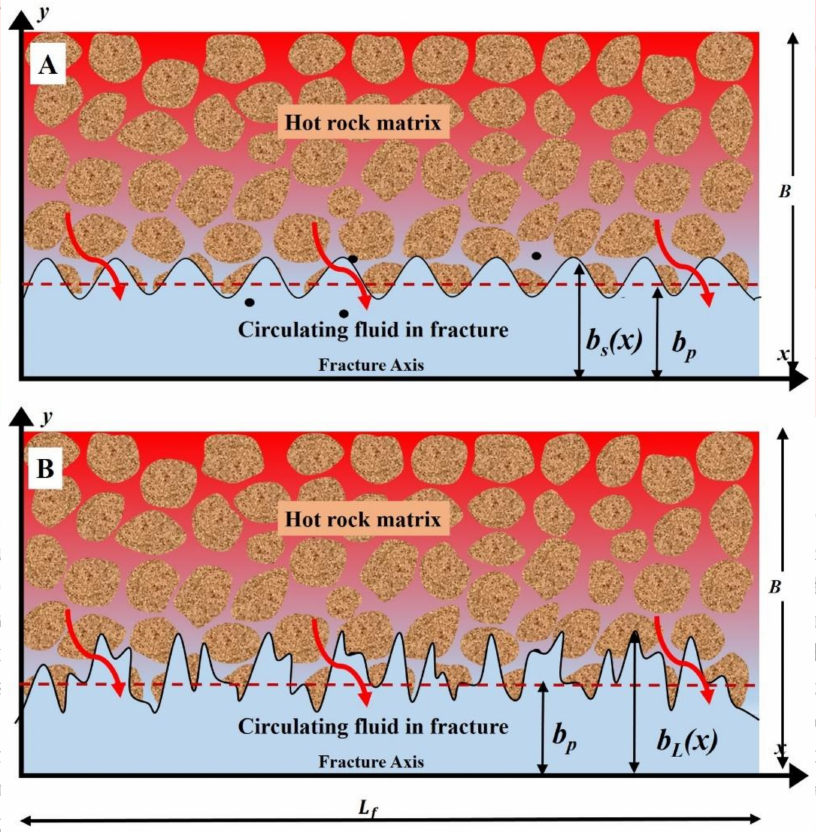
Figure 2. Schematic diagram showing the fracture aperture obtained from parallel plate, sinusoidal ( B ), and linear congruential generator (LCG)-aperture ( A ) models in a single horizontal fracture-rock matrix